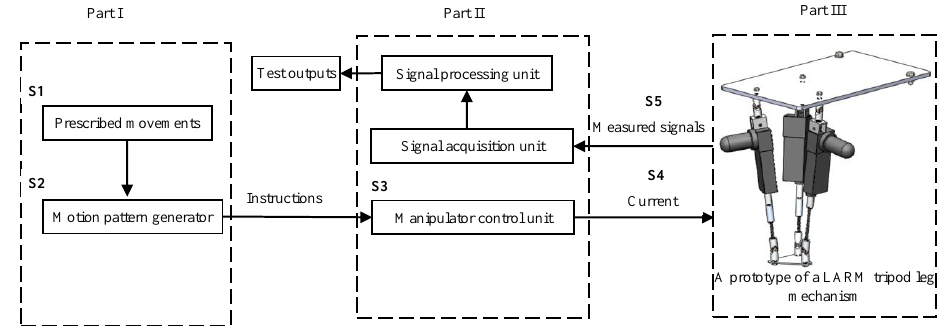
Figure 5. A schematic diagram of the experimental layout in Fig. 4 for an operation